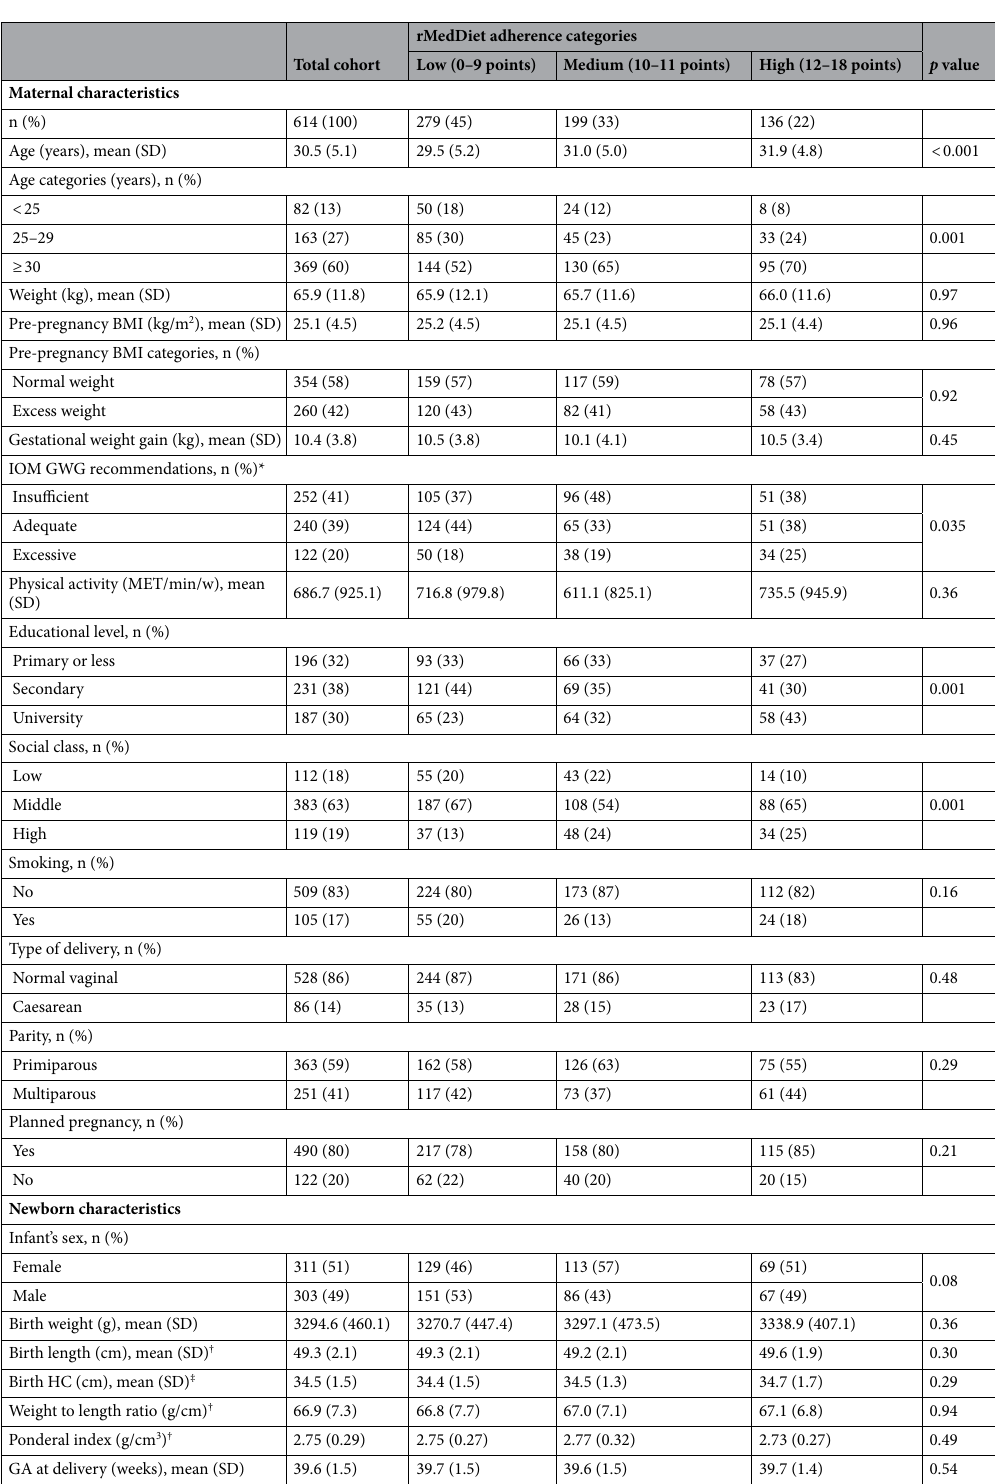
Table 1. General maternal and child characteristics according to Mediterranean Diet adherence categories during pregnancy (n = 614). Values are expressed as a mean (± SD, standar desviation) or number (%). BMI body mass index, GWG gestational weight gain, rMedDiet Mediterranean diet, HC head circumference, GA gestational age. p values for differences across the three MedDiet adherence categories were calculated with the Chi-square test or ANOVA. *Recommendations for GWG by the IOM guidelines are for initial BMI < 18.5 kg/ m 2 total weight gain between 12.5–18 kg; for BMI of 18.5 to 24.9 kg/m 2 total weight gain between 11.5 and 16 kg; for BMI of 25.0–29.9 kg/m 2 total weight gain between 7 and 11.5 kg; and for BMI ≥ 30 kg/m 2 total weight gain between 5 and 9 kg. † n = 495. ‡ n =